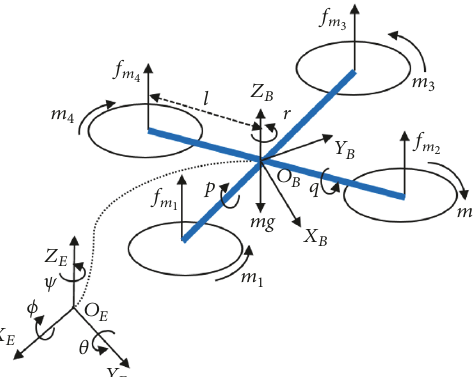
Figure 1: Free body diagram of quadrotor.